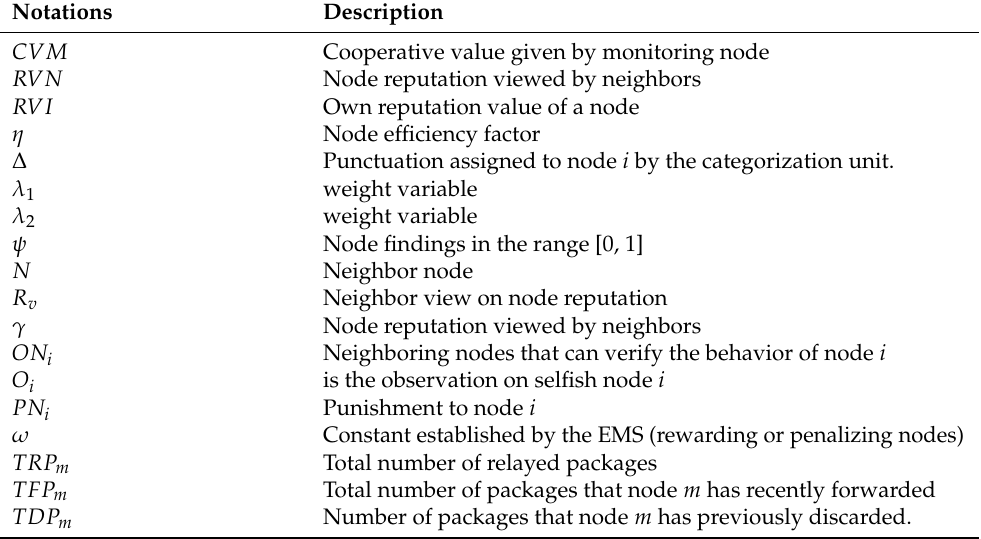
Table 2. Notations used in the Proposed